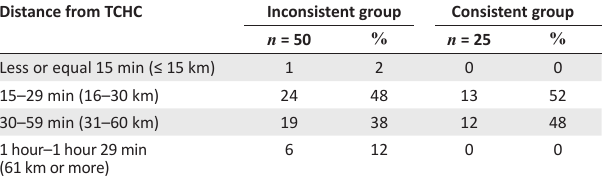
TABLE 2: Distances between the stroke survivors’ residences and the Community Health Centre ( n = 75). Distance from